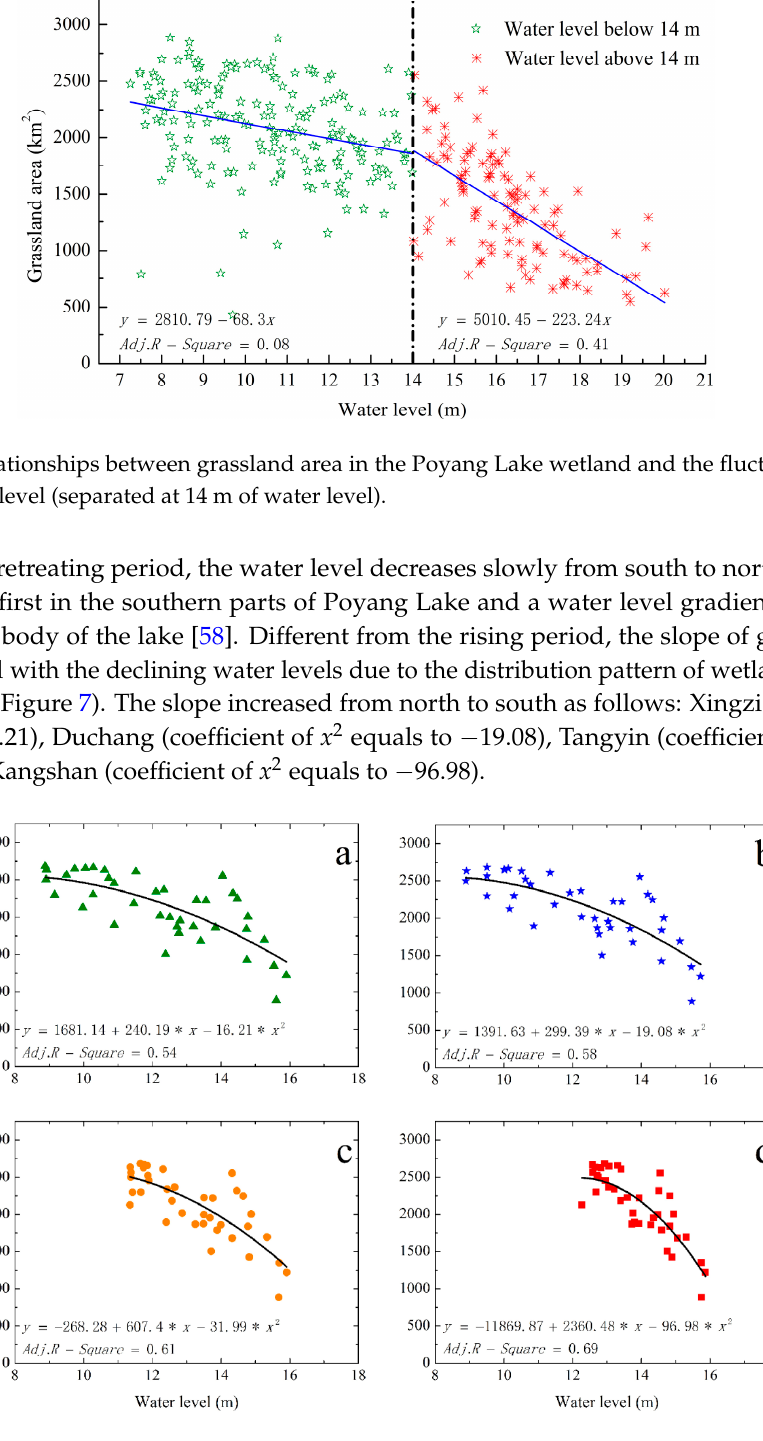
Figure 7. Relationships between grassland area and water level fluctuations (( a ) Xingzi; ( b ) Duchang; ( c ) Tangyin; ( d ) Kangshan) during the retreating period.